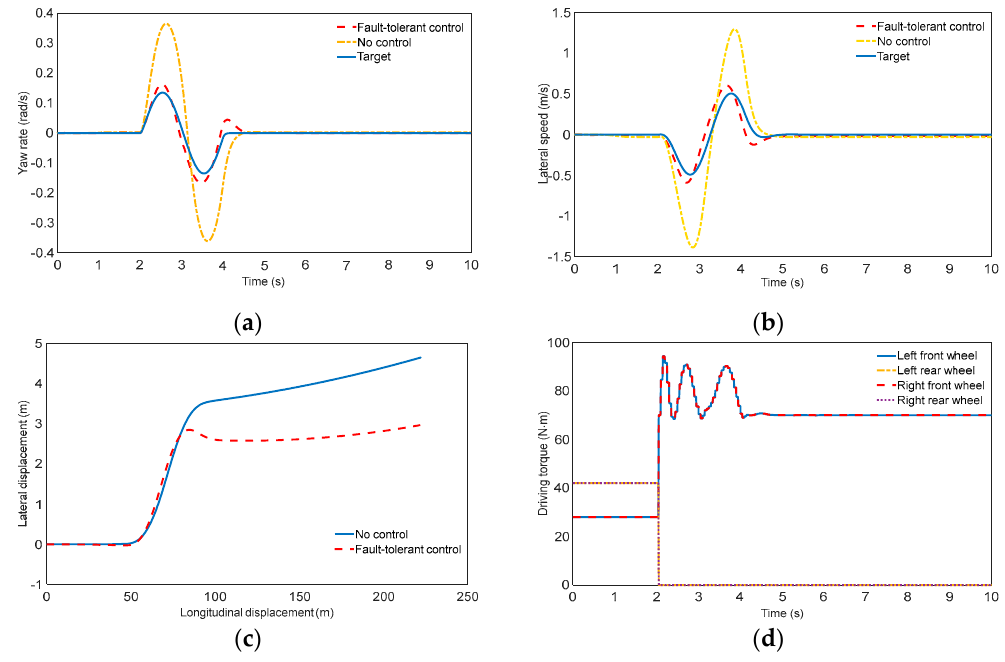
Figure 7. Results of the two failed wheels in sinusoidal steering: ( a ) Yaw rate; ( b ) Lateral speed; ( c ) Motion trajectory; ( d ) Drive torque.